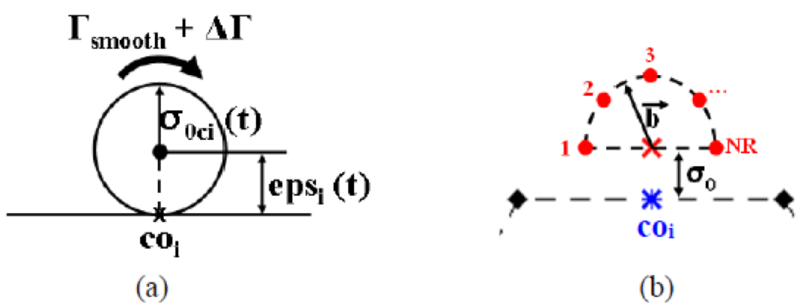
Figure 4. ( a , b ) Shedding of a vortex blob during one time stepping ( co i is the pivotal point and eps i ( t ) defines the “rough shedding point” location of the vortex blob).